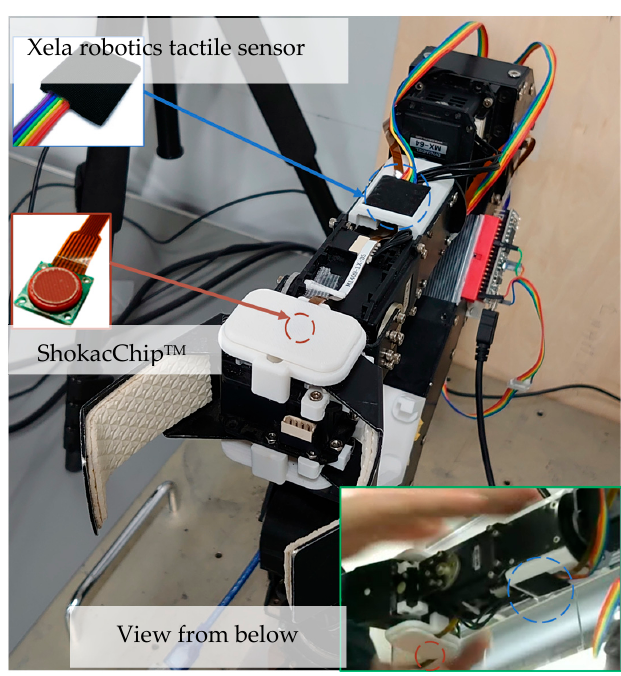
Figure 6. Robot arm equipped with the sensors, used to collect touch behaviors.